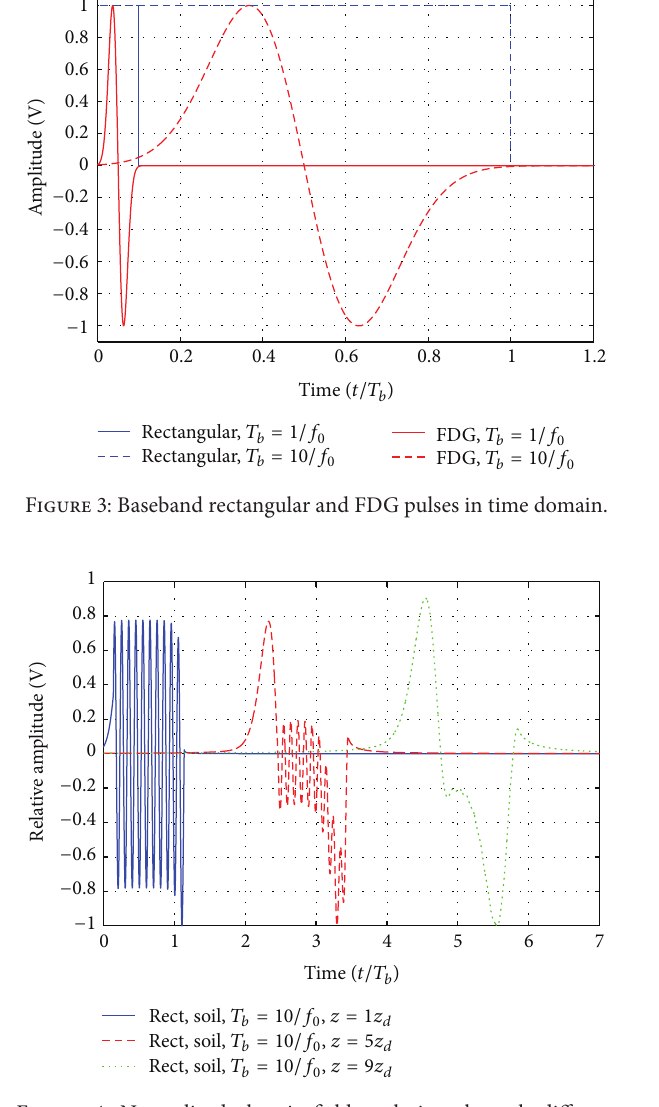
Figure 4: Normalized electric field evolution through different propagationdistanceswithinadielectricslabofsoilforarectangular pulse with 𝑓 = 1.5 GHz and 𝑇 𝑏 = 10/𝑓 0 .